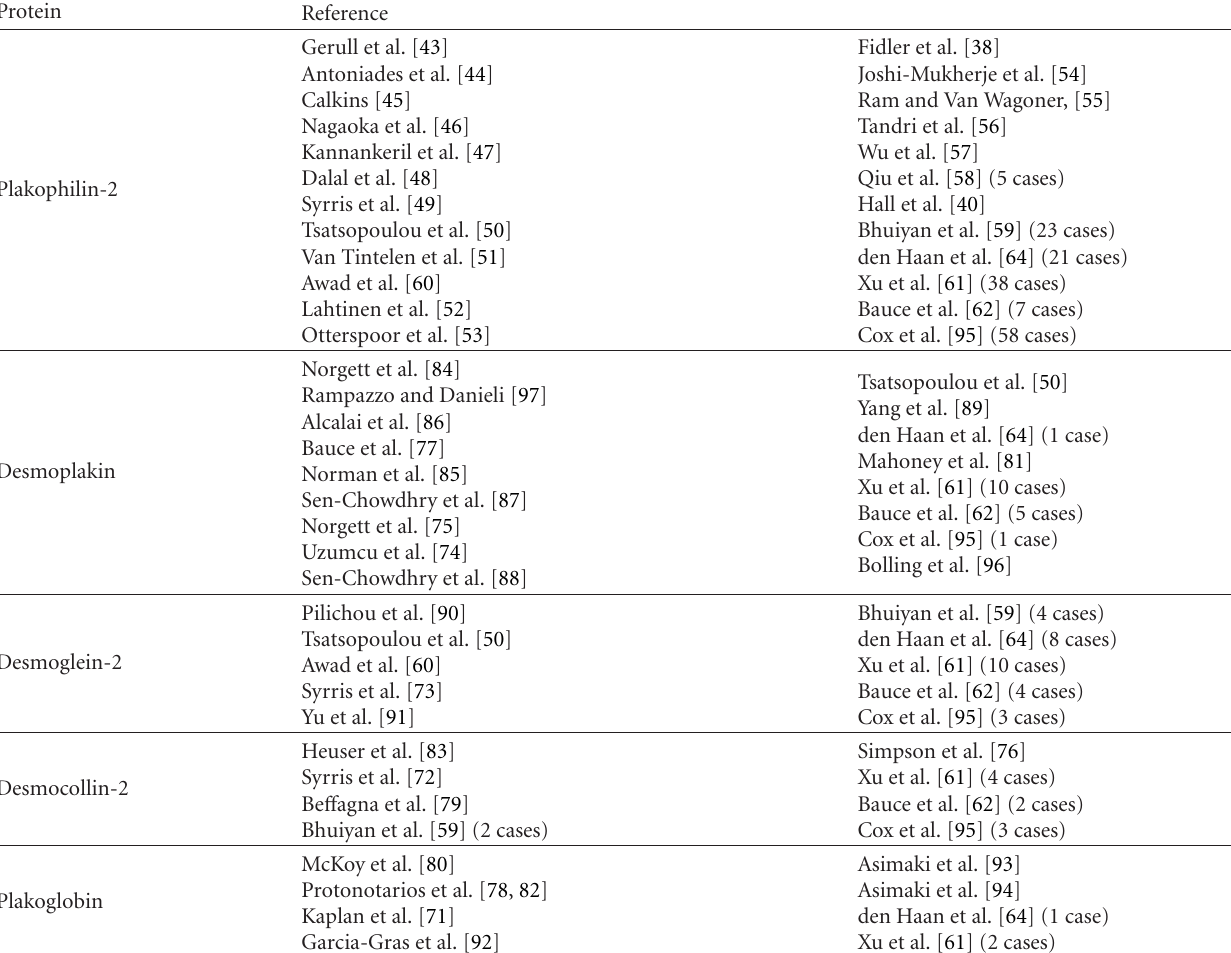
Table 2: During the last few years an avalanche of publications has appeared—and is still continuing to do so—showing the involvement of mutations in desmosomal components in the development of arrhythmogenic cardiomyopathies, including “sudden death” cases (for references see [10–12, 38, 40, 42–96]). Recent references reporting that certain mutations in human genes encoding desmosomal proteins and glycoproteins contribute to arrhythmogenic ventricular cardiomyopathies